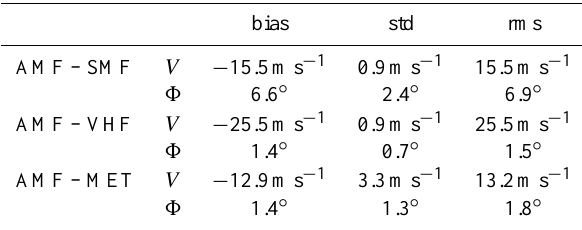
Table 3. Comparison of mesospheric wind estimations between the AMF radar and other available radar instruments using the SA methods (bias, standard deviation, and rms